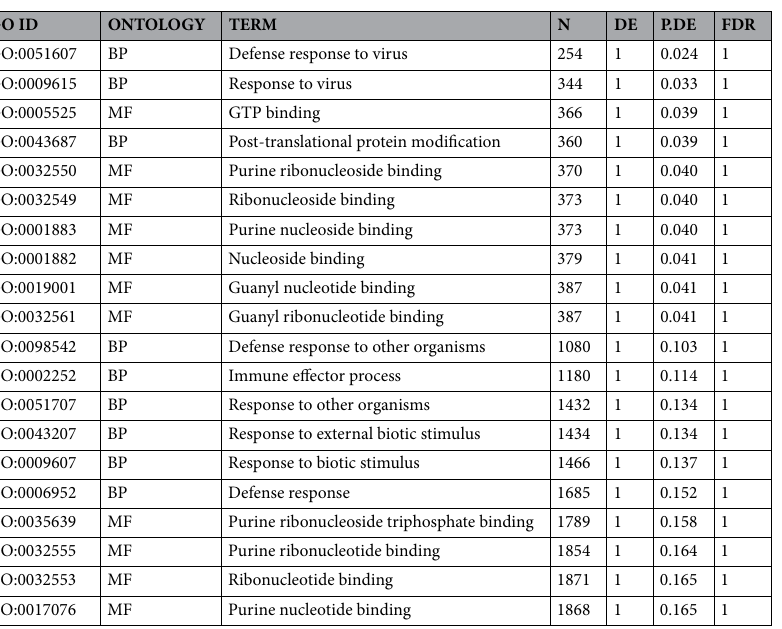
Table 2. The top 20 most enriched gene ontology (GO) pathways for the comparison between COVID-19 positive and COVID-19 negative individuals. ‘BP’ stands for biological process, ‘MF’ for molecular function, ‘N’ for number of genes in the GO term, ‘DE’ for number of genes found to be differentially methylated, ‘P.DE’ for P-value for over-representation of the GO term, and ‘FDR’ for false discovery